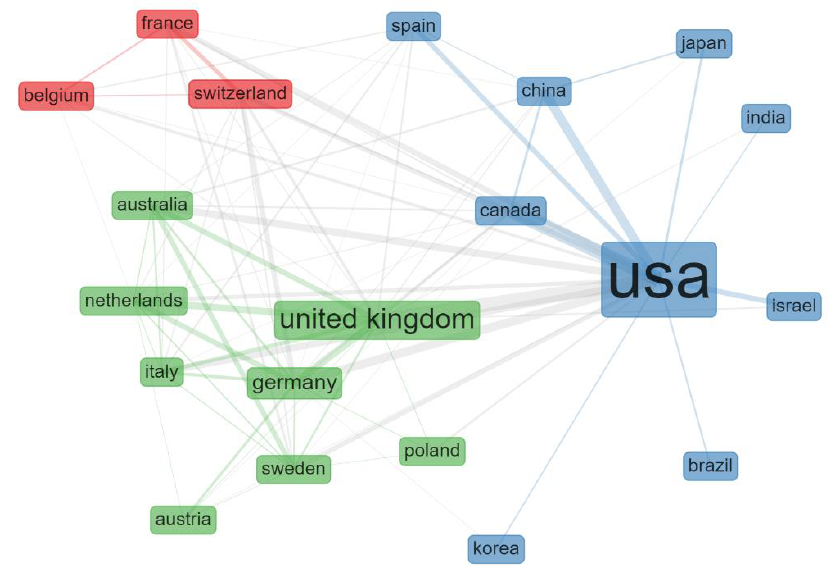
Figure 4. Country collaboration network of articles retrieved in the search. The size of the country’s name is proportional to the number of articles retrieved for that